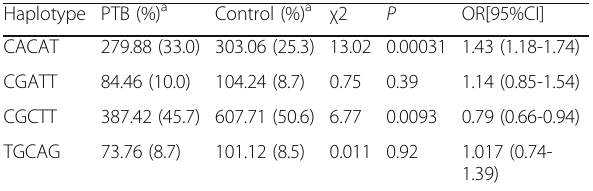
Table 5 Estimated frequencies of haplotypes consisting of EREG SNPs in PTB and controls Haplotype PTB (%) a